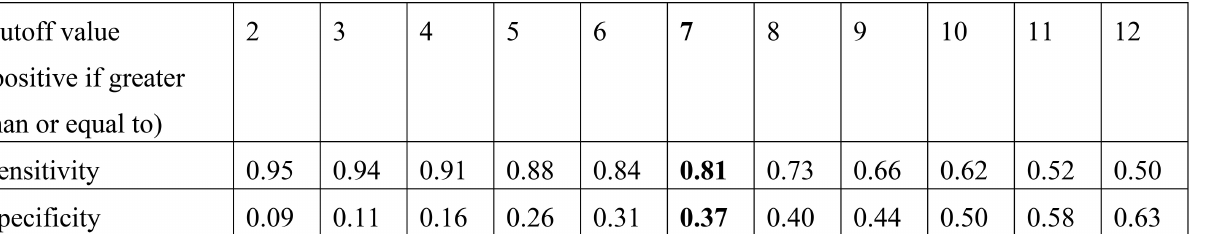
FIGURE 2 | Sensitivity and specificity for each cut-off of the HCL-33-EA total score when comparing MDD and BD in